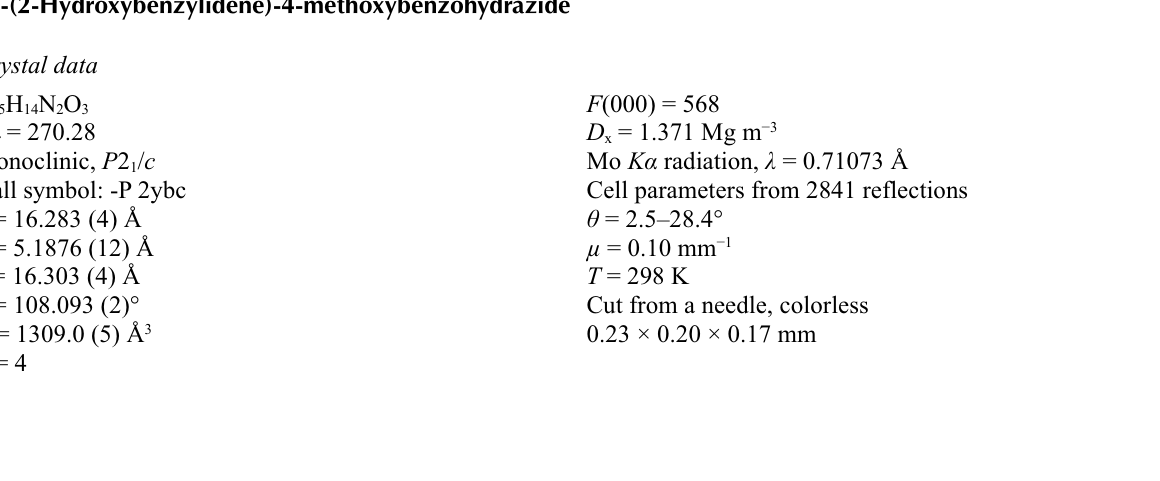
Molecular packing of (I) with hydrogen bonds drawn as dashed lines. N ′